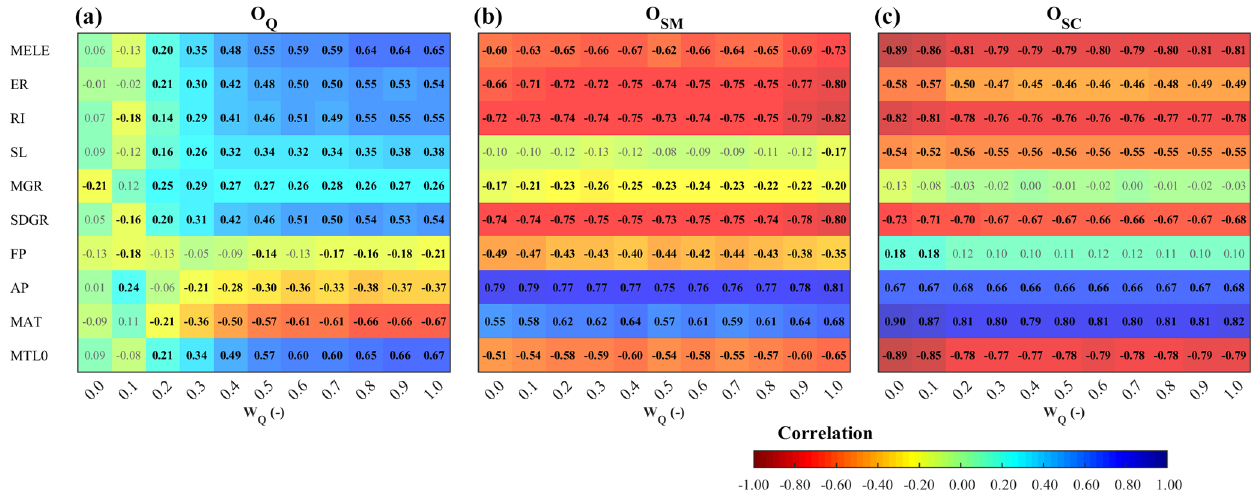
Figure 5. Correlation between catchment attributes (Table 1; other attributes can be found in Fig. S1) and model performance, i.e., runoff (Eq. 2; a ), soil moisture (Eq. 5; b ), and snow cover (Eq. 6; c ) obtained from multiple objective calibration to satellite soil moisture (ASCAT), satellite snow cover (MODIS), and runoff (var3 of Table 4; SSM + SCM + runoff) in the calibration period 2000–2010. Cool and warm colors represent positive and negative correlations, respectively. Tex in bold indicates significance with p values lower than 0.05.